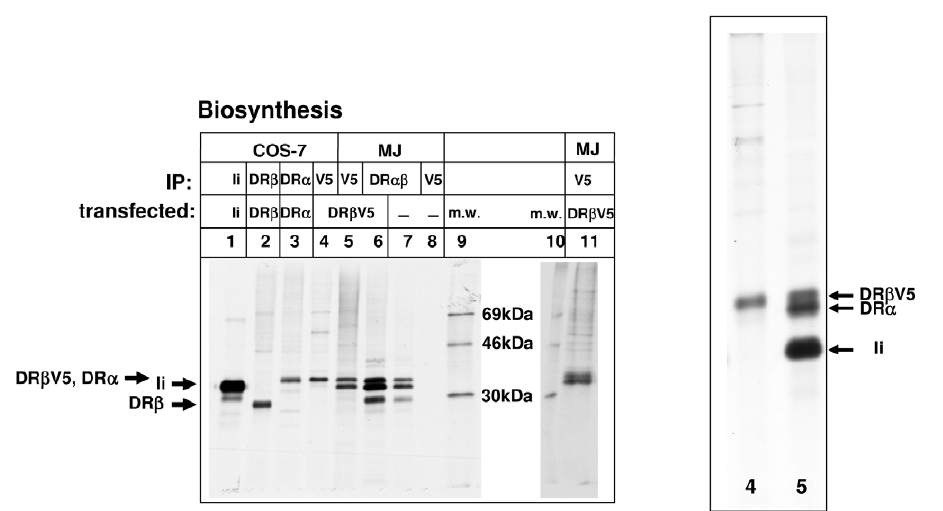
Figure 8. Metabolic labeling reveals that only one DR b chain associated to an Ii homotrimer. The composition of DR-Ii complexes in pulse labeled immunoprecipitates from MelJuSo cells, stably transfected with DR b V5 encoding cDNA. COS cells and MelJuSo cells expressing MHCII subunits and Ii were pulse labeled for 10 min with 35 S-methionine. Cells were lysed and immunoprecipitated for Ii (monoclonal antibody Bu45, lane 1), for DR b (S35, lane 2), for DR a (monoclonal antibody TAL-1B5, lane 3), for DR b V5 (monoclonal antibody V5, lanes 4 and 5), for DR ab (monoclonal antibody I251SB, lanes 6 and 7) and as a control of reactivity of V5 monoclonal antibody with untransfected MelJuSo cell extract (monoclonal antibody V5, lane 8). Lanes 9 and 10 show molecular weight standards. In lane 11 a DR b V5 immunoprecipitate of MelJuSo cells which were pulse labeled for 10 min with 35 S methionine and subsequently cultured for 40 min with medium containing non-radioactive methionine is shown. Immunoprecipitates from lanes 4 and 5 (left panel) were separated on a 20 cm long SDS PAGE gel to separate DR b V5 and DR a chains (right panel).